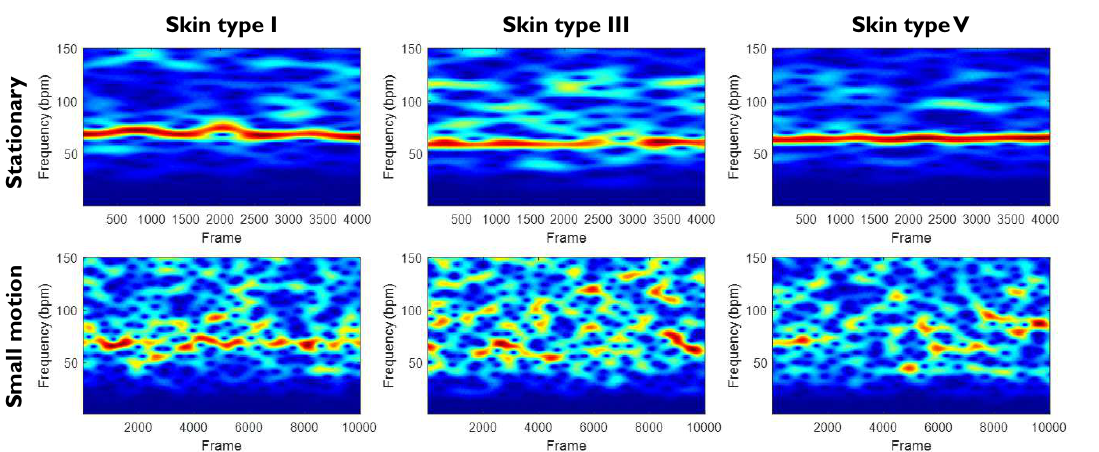
Figure 3. The pilot measurement of PPG spectrograms measured from three subjects (with different skin types) in two different scenarios (stationary and small motion). The light source was the multi-wavelength narrow-band LED light source configuration shown in Figure 1c including a diffuser.